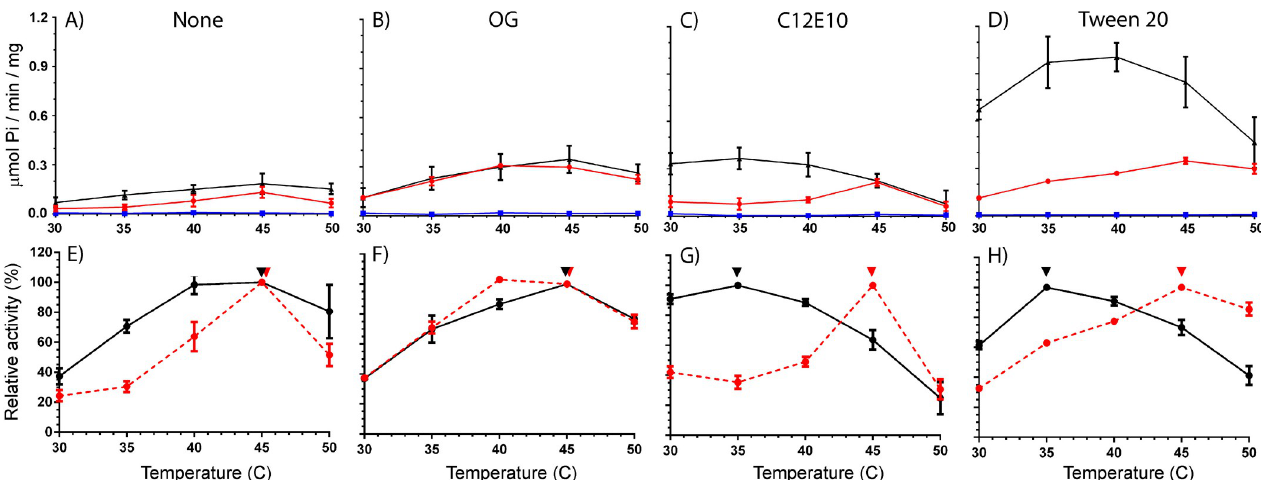
Fig 6. ATPase activity of Spf1p and M1 mutated Spf1p in mixed YPL/detergent micelles. A-D) Specific activity in μ mol Pi/min/mg at indicated temperatures in absence of detergent (control) or in the presence of 0.35% (w/w) detergent as indicated. Spf1p (black), Spf1p-F202A,F204A,F207A (red) and Spf1p-F202H,F204H,F207H (blue). All experiments are performed as biological replicates and technical triplicates ( n = 6) and is reported as the average value of these with error bars indicating the standard error (except cholate in 1A, n = 2 and only average value reported). E-H) The same data plotted as relative